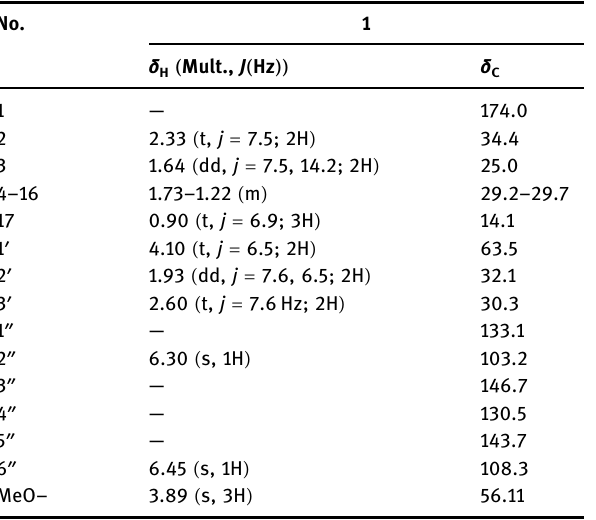
Table 2: 1 H and 13 C NMR data for compounds 2 ( DMSO - d 6 , δ in ppm, 500 and 126 MHz